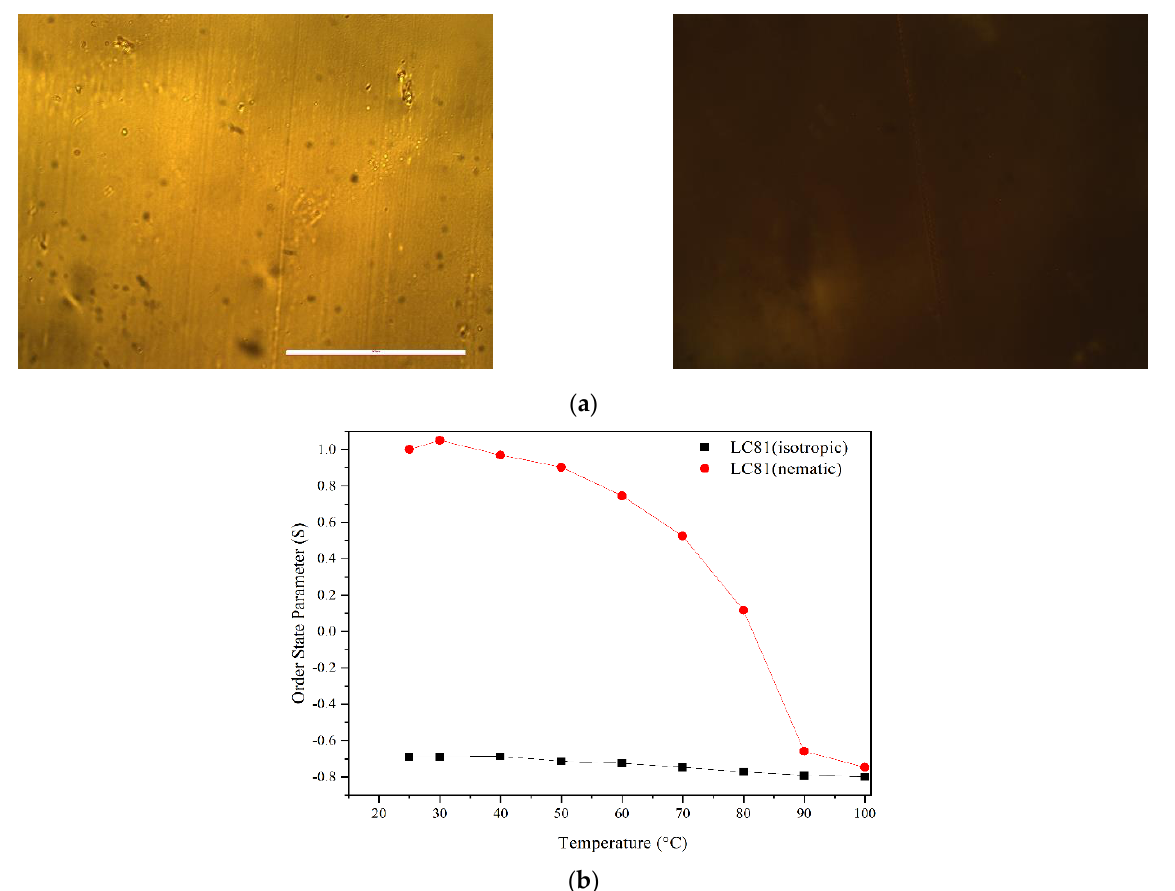
Figure 5. ( a ) Polarized microscopy images of LC18, showing the birefringence properties of the materials. The bar represents 200 um. ( b ) Order state parameter of LC81 measured at various temperatures (probe wavelength λ = 633 nm).